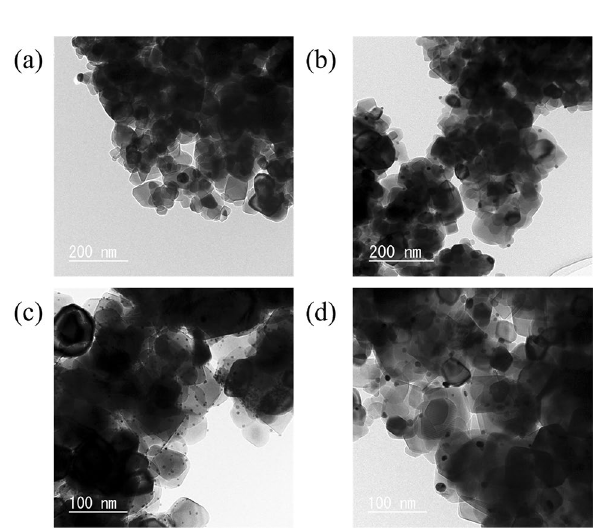
Fig. 8 Transmission electron microscopy images of the synthesized AuNP/TiO /CaCO (X g) catalysts; X = a 0, b 0.4, c 0.8, and d 4.0 g 2 3